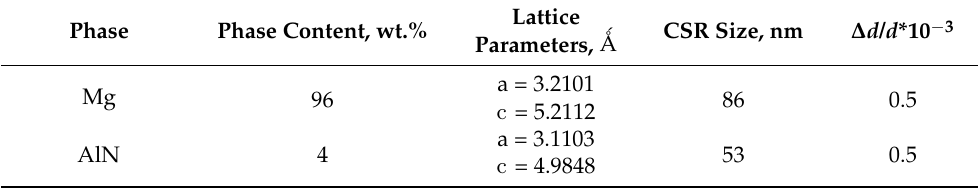
Lattice Parameters,